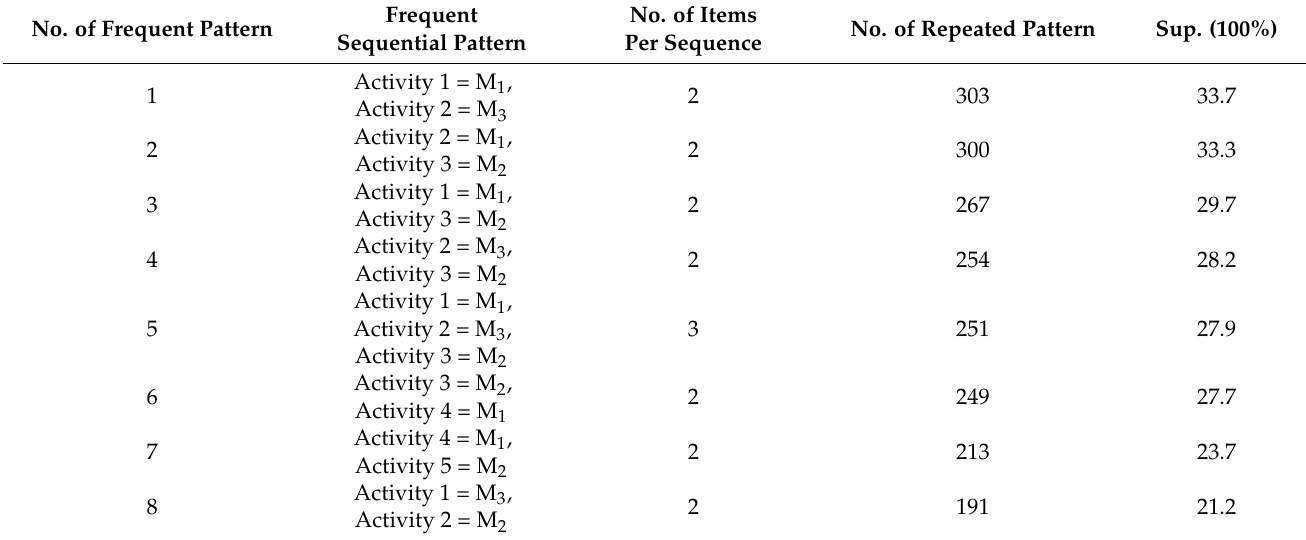
Table 8. Frequent sequential patterns of maintenance